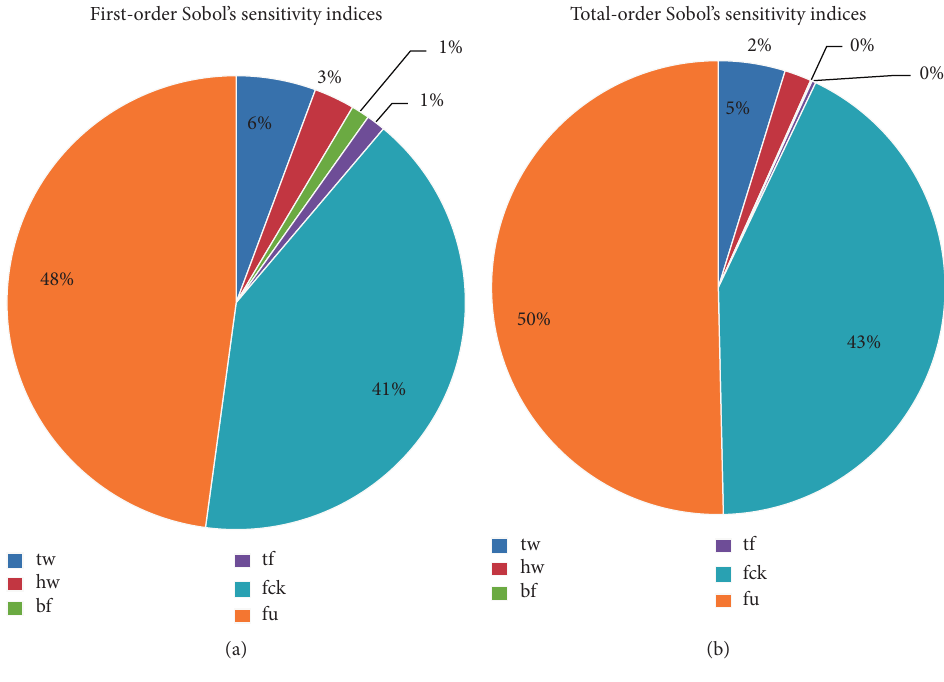
Figure 9: First-order and total Sobol’s sensitivity indices of the SCC beams at the pristine condition.